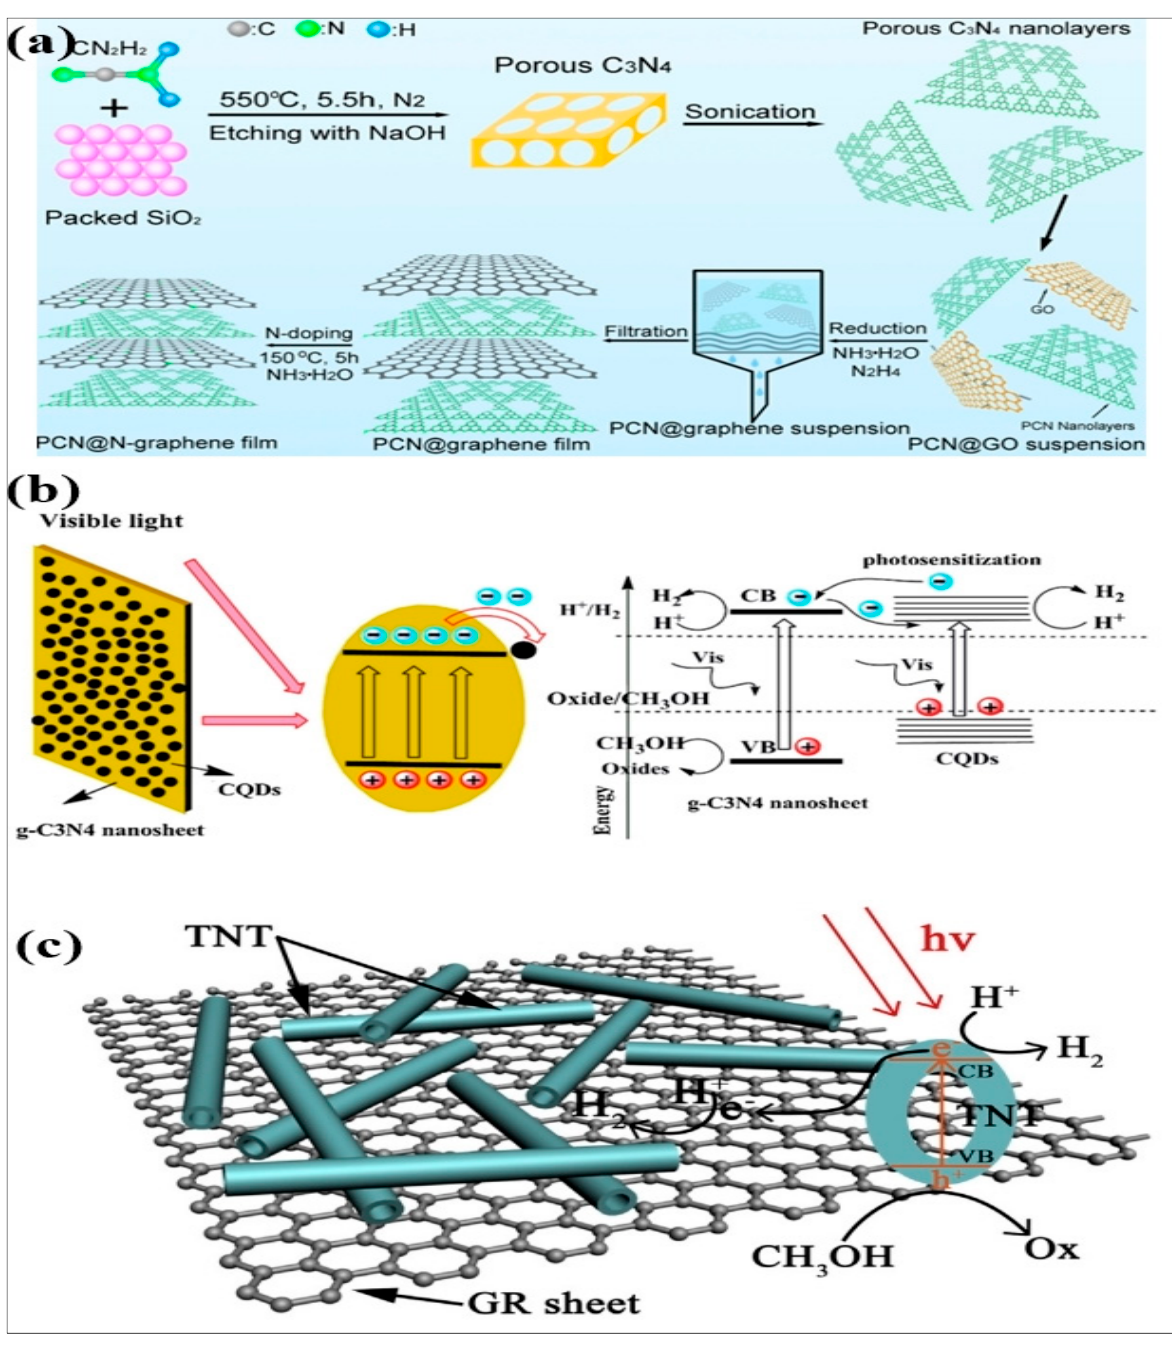
Figure 10. ( a ) Schematic representation for synthesis of PCN@N-graphene film, (Reprinted [158] copyright 2015 American Chemical Society) ( b ) graphical presentation of the photocatalytic mecha- nism of UCN/CQDs photocatalyst under visible light, (Reprinted with permission from [159] Elsevier, Li-cense No. 5402970976855) ( c ) charge transfer mechanism in TNT/GR photocatalyst under Xe-lamp. (Reprinted with permission from [160] Elsevier, License No. 5400000373804).